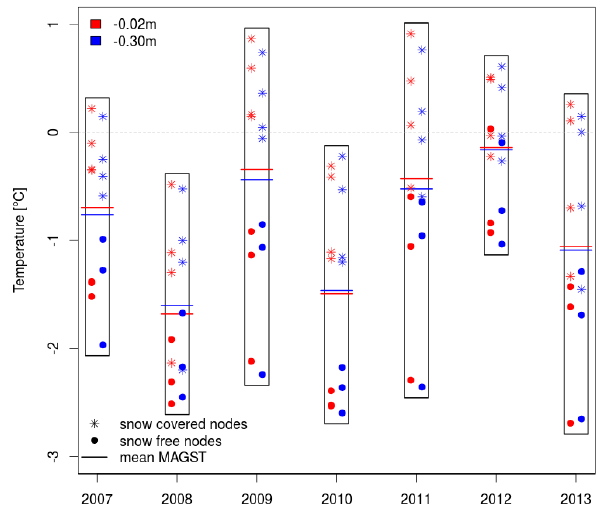
Figure 4. Mean annual ground surface temperatures at depths of 0.02m (red) and 0.3m (blue). Star symbols indicate snow-covered nodes, while bullets indicate snow-free nodes. The horizontal lines indicate the mean MAGST for each year and each depth. Black rect- angles are used to highlight the min–max envelope to facilitate the inter-annual